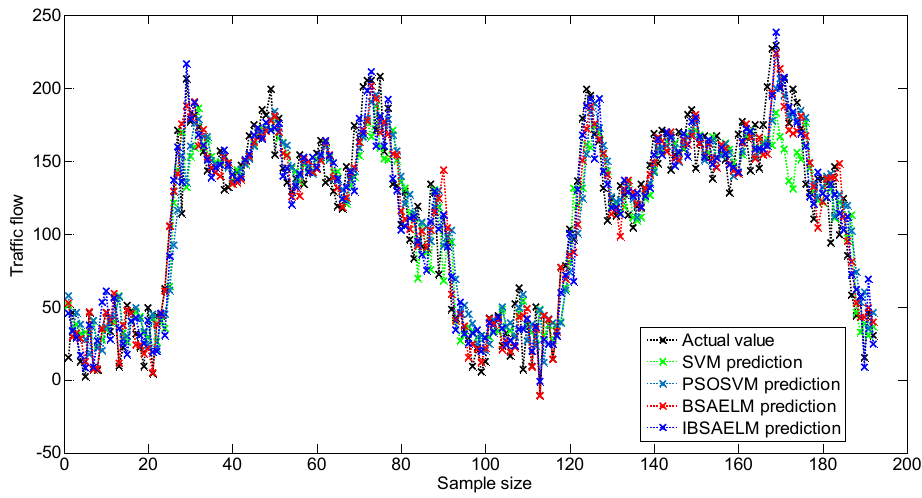
Figure 6. Prediction results of traffic flow series for two days.